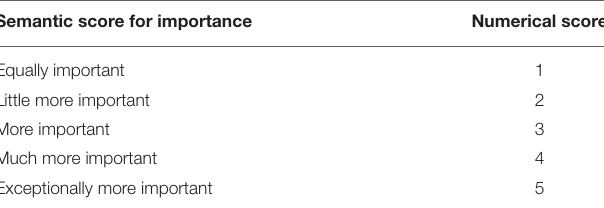
TABLE 1 | Scale of semantic operators and relative score adopted in survey